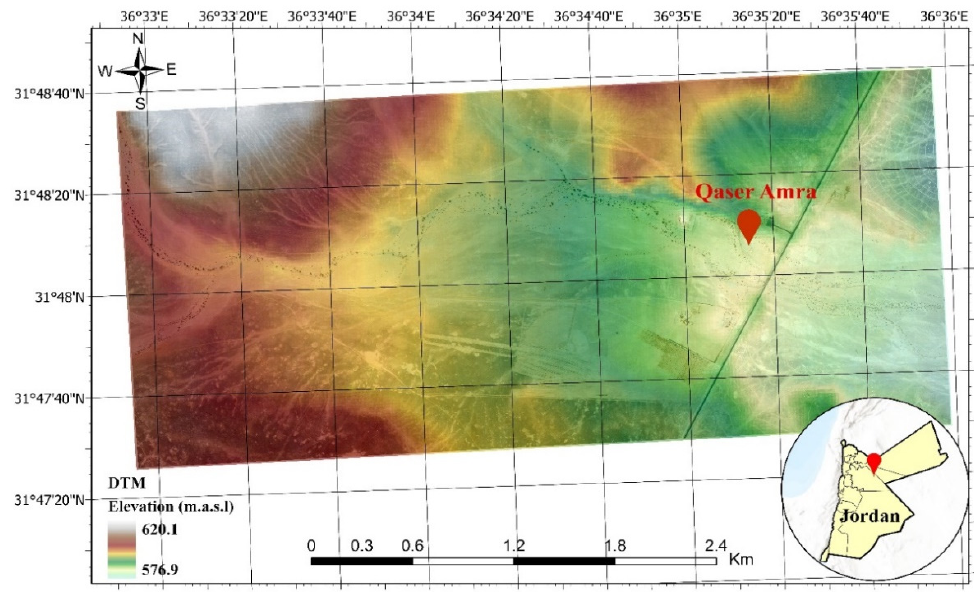
Figure 9. Digital elevation model (DEM) of the Qaser Amra area.